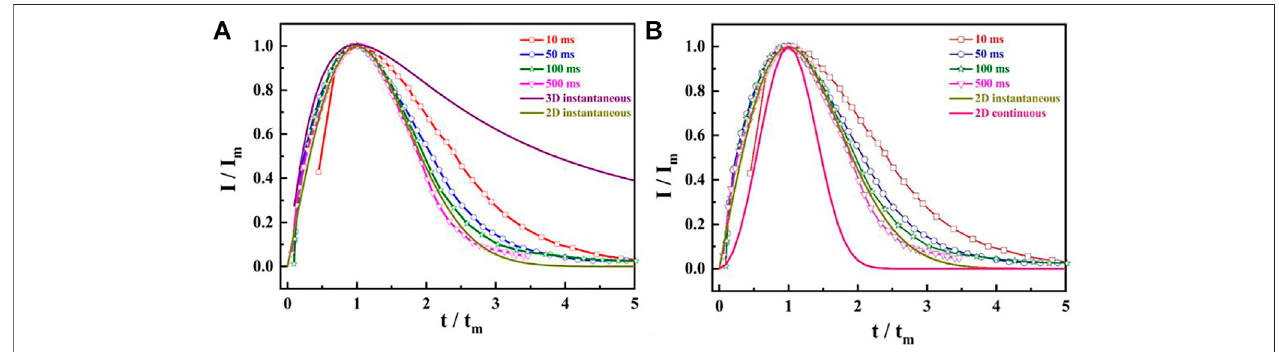
FIGURE 2 | The dimensionless ( I / I m ~ t / t m ) curves at different adsorption times: (A) 2D and 3D instantaneous model; (B) 2D instantaneous and continuous model.